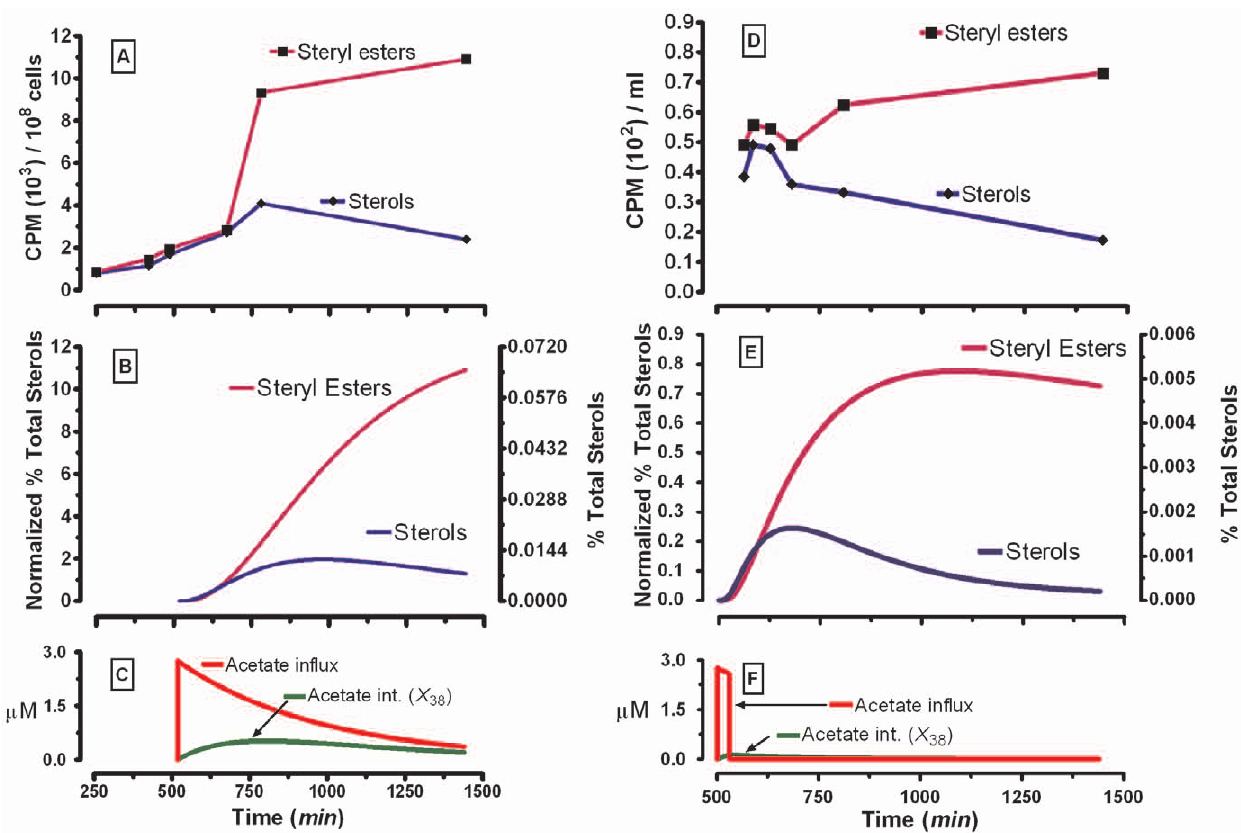
Figure 3. Experimental data vs. SL-E model simulation results for steryl-esters and total sterols. After an external pulse bolus (Panels A– C ). ( A ) Dynamics adapted from Taylor and Parks [42] after pulse-chase bolus of [ 14 C ]-Acetate. ( B ) Simulation for total steryl-esters ( X 33 + X 34 + X 35 + X 40 ) and total sterols ( X 30 + X 31 + X 32 + X 36 + X 37 + X 39 ) after pulse bolus of labeled acetate. ( C ) Transported external label acetate ( X 125 ) and cytoplasmic acetate ( X